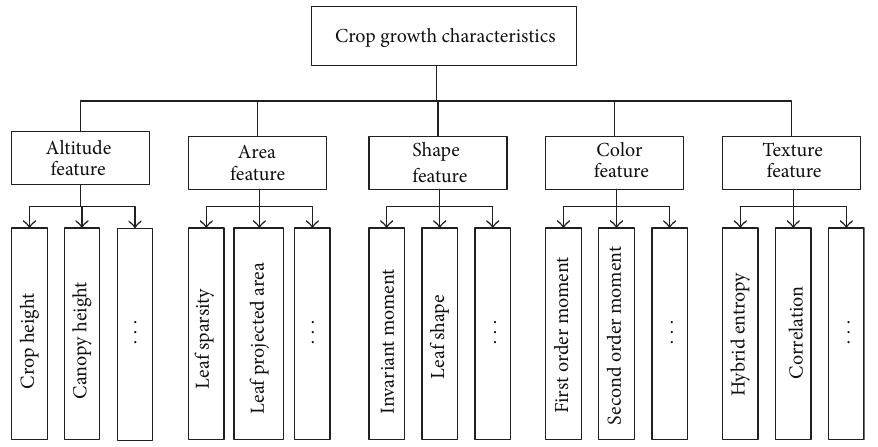
Figure 1: Schematic image of growth feature